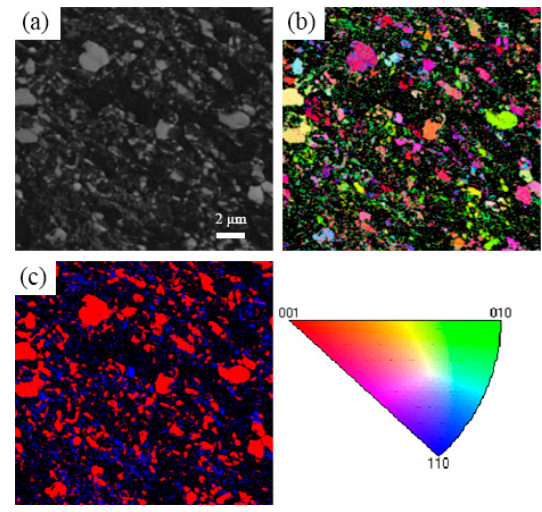
Figure 8. EBSD images of TBC YSZ-2 after heat treatment at 1550 °C/100 h: ( a ) quality maps; ( b ) orientation maps; ( c ) phase maps; The orientations are defined by tetragonal lattice symmetry.